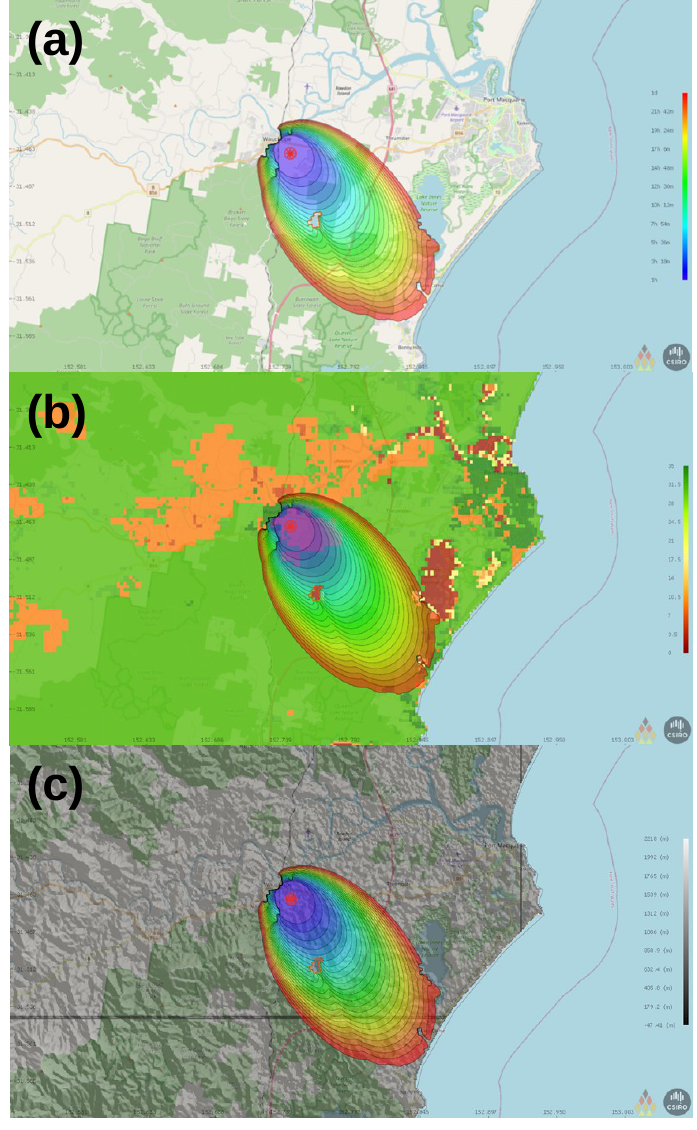
Figure 16. Simulation results of fire spread in the Wauchope region over a 24 h period: ( a ) basemap; ( b ) with vegetation-type basemap; ( c ) with terrain